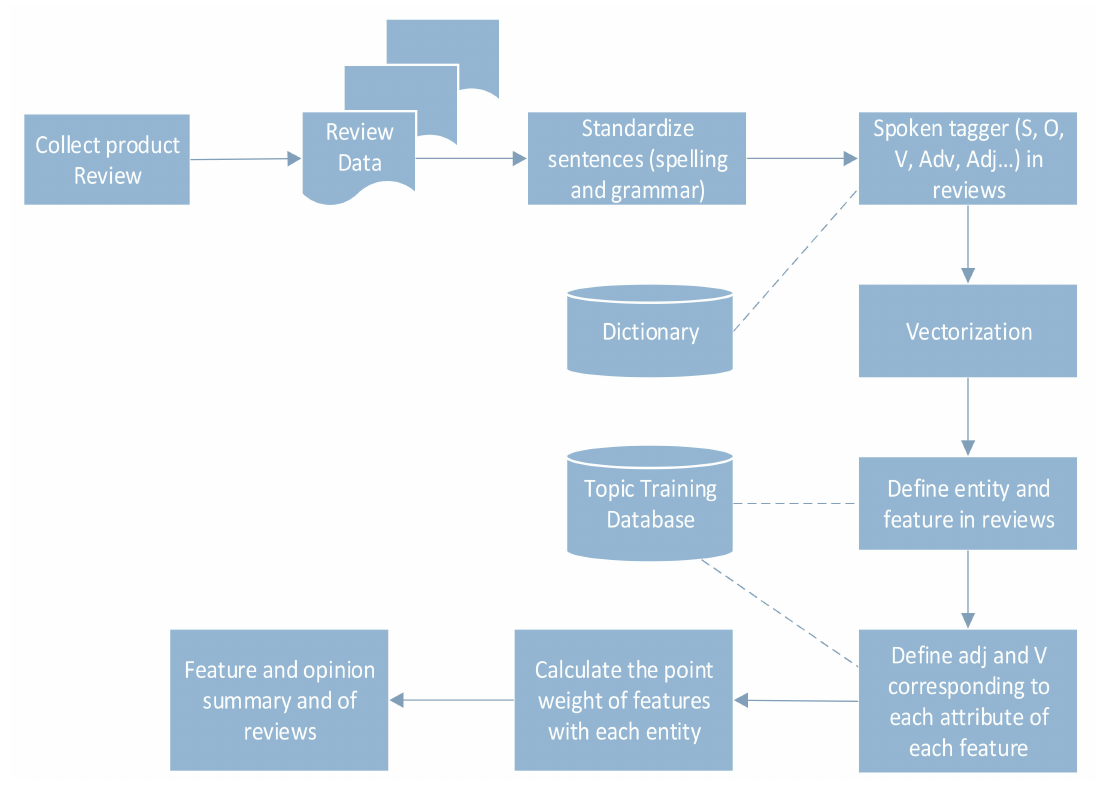
Figure 6. Topic modelling